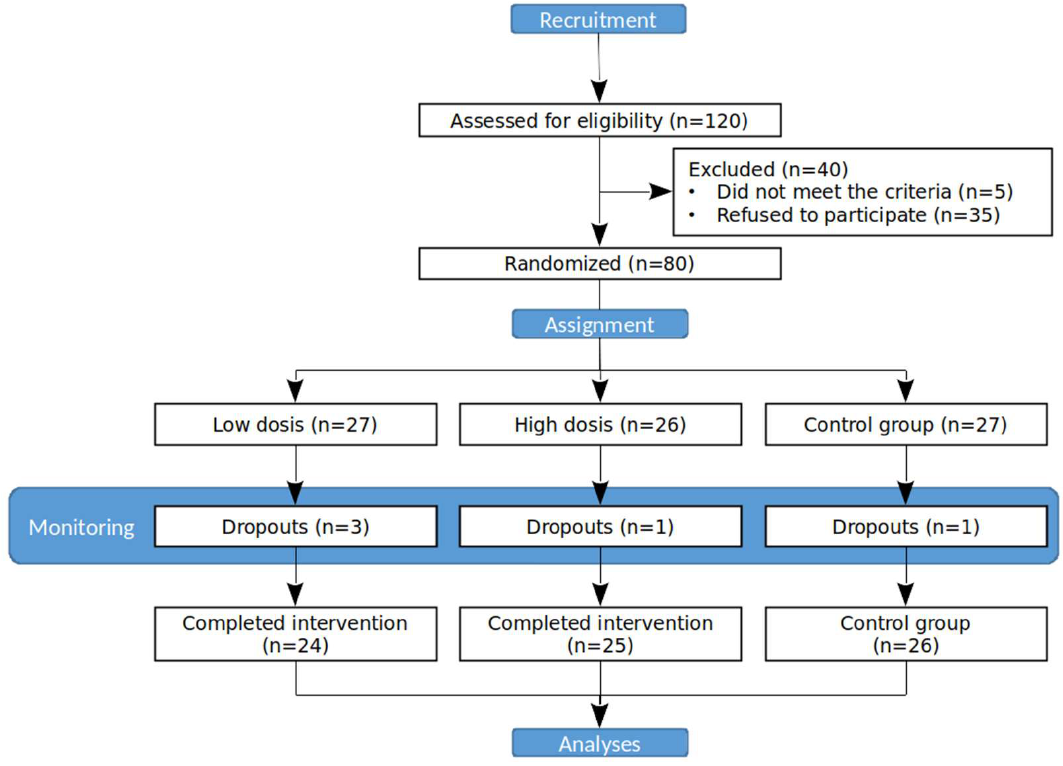
Figure 1. Flowchart representing the different stages of the trial. Randomisation profile shows flow of patients in the three groups: high-dose (500 mg), low-dose (300 mg), and control group.